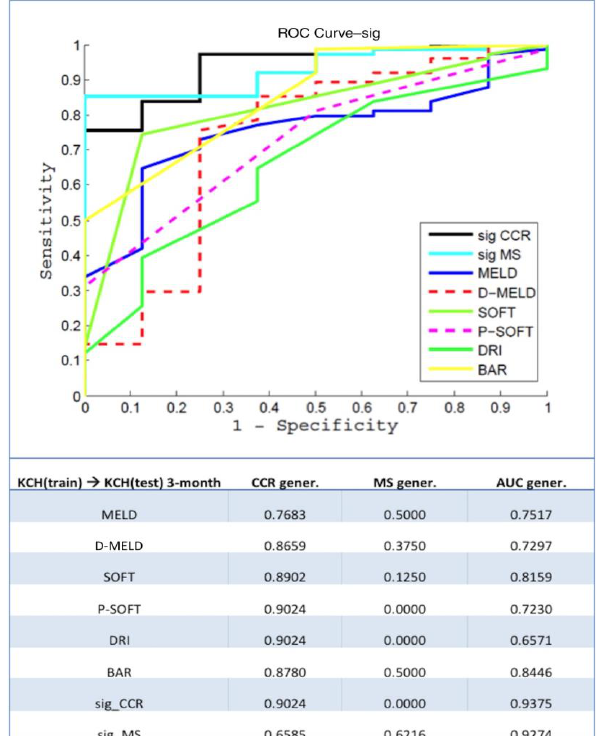
Figure 4. 3-month graft survival model based on ANN compared to other scores using the KCH database. CCR (correct classification rate or accuracy), MS (minimum sensitivity), and AUC (area under curve) values are shown. Figure obtained from Ayll ó n MD et al. [21] © 2022 by the American Association for the Study of Liver